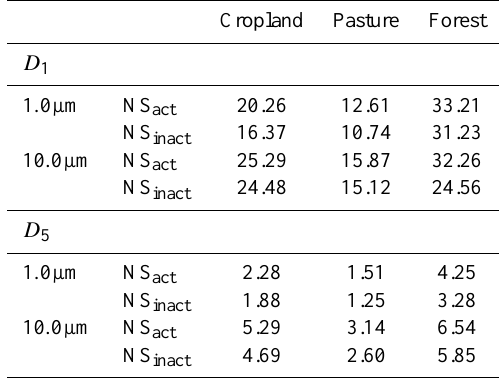
Table 5. Average area (in 10 3 km 2 ) covered with high relative de- position, D 1 and D 5 . Cropland